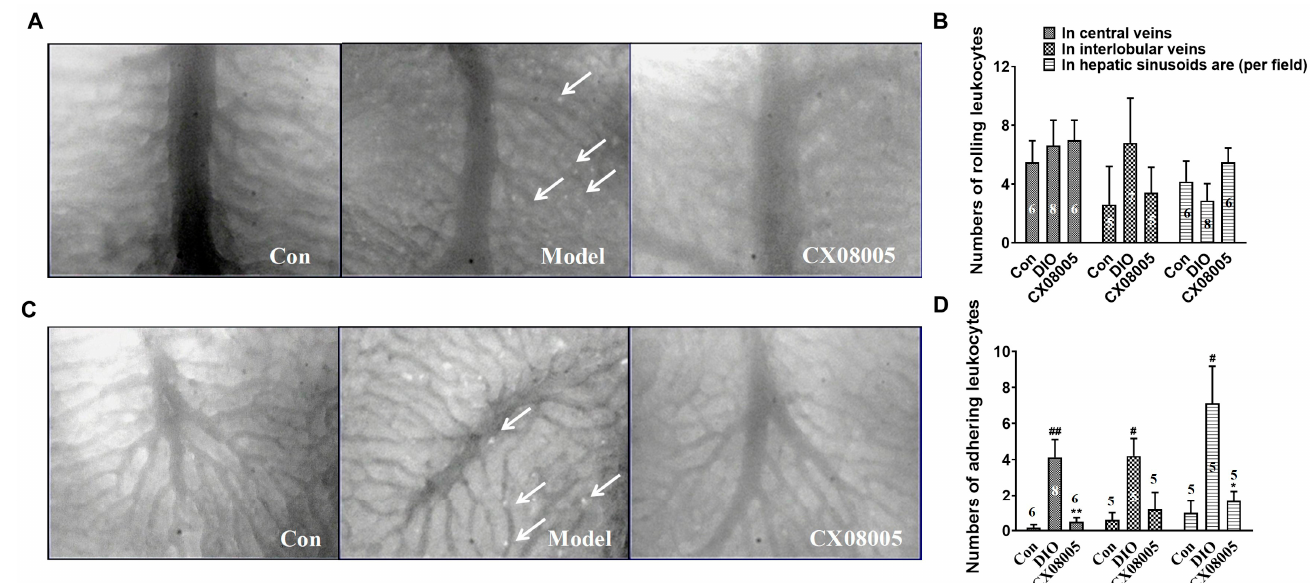
Figure 6. Effects of CX08005 on rolling and adhering leukocytes in DIO mice. ( A ) Adhering leukocytes in central veins (×200); ( B ) Numbers of rolling leukocytes; ( C ) Adhering leukocytes in interlobular veins (×200); ( D ) Numbers of adhering leukocytes. Data are shown as means ± SEM. N = 5 − 8. # p < 0.05, ## p < 0.01, vs. Con; * p < 0.05, ** p < 0.01 vs. DIO mice. White arrows indicate rolling/adherent leukocytes in central veins or interlobular veins.